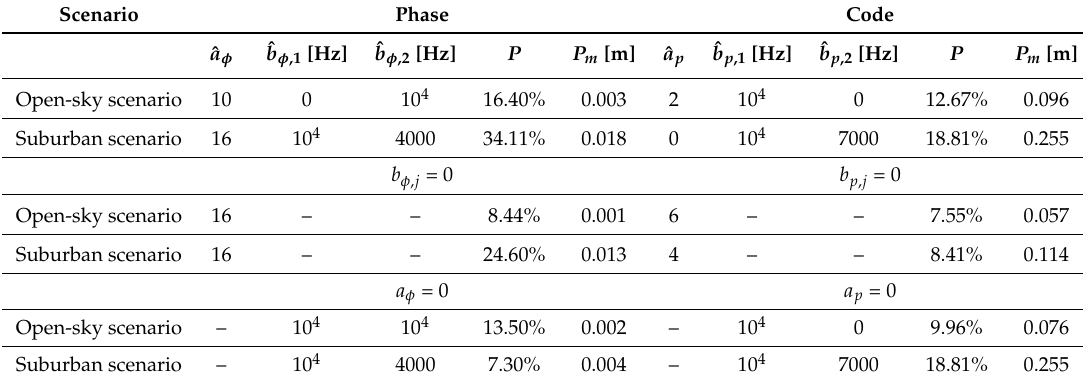
Table 2. The weighting coefficients (Equations (16) and (17)) leading to the smallest mean value in the positional results and the improvement ratios P of the mean of 3D positioning errors compared to the case that all the weighting coefficients are set to zero (i.e., no weighting model used). P m refers to the actual improvement in the mean of the 3D positional errors.